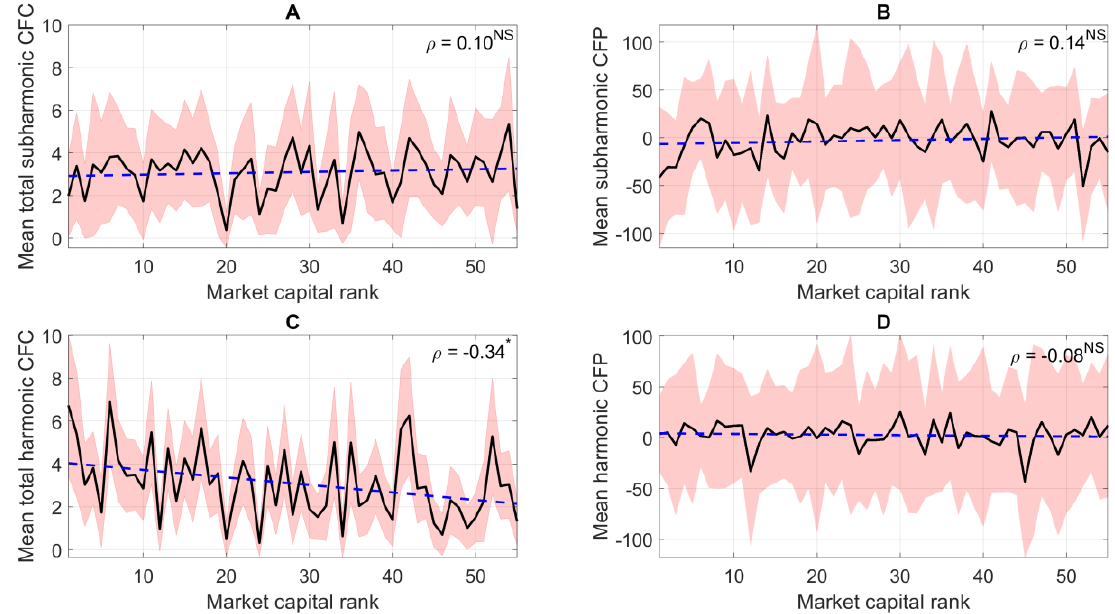
Fig. 5A. Total subharmonic cross-frequency coupling (CFC) vs. market capital rank. The total subharmonic CFC mean ± std for each cryptocurrency along with the linear fit to the mean curve (mean total subharmonic CFC = 0.006 × market capital rank + 2.9) is shown. 5B. Mean subharmonic cross-frequency coupling phase (CFP) vs. market capital rank. The grand mean ± std of subharmonic CFC phases for each cryptocurrency along with the linear fit to the mean curve (grand mean subharmonic CFP = 0.14 × market capital rank – 6.74) is shown. 5C. Total harmonic cross-frequency coupling (CFC) vs. market capital rank. The total harmonic CFC mean ± std for each cryptocurrency along with the linear fit to the mean curve (mean total harmonic CFC = -0.03 × market capital rank + 4.0) is shown. 5D. Mean harmonic cross-frequency coupling phase (CFP) vs. market capital rank. The grand mean ± std of harmonic CFC phases for each cryptocurrency along with the linear fit to the mean curve (grand mean harmonic CFP = -0.06 × market capital rank + 4.33) is shown. Phase values are in degrees and range from -180 to +180. (mean ± std = black curve ± red shaded region; linear fit = blue dashed line; NS = not significant, p > 0.05; * p <=